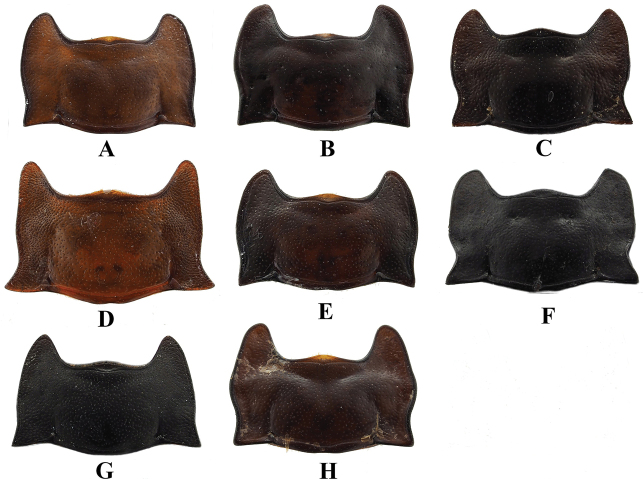
Pronotum of Sinocymbachus spp. AS.
angustefasciatusBS.
bimaculatusCS.
decorusDS.
excisipesES.
humerosusFS.
luteomaculatusGS.
parvimaculatusHS.
quadrimaculatus.